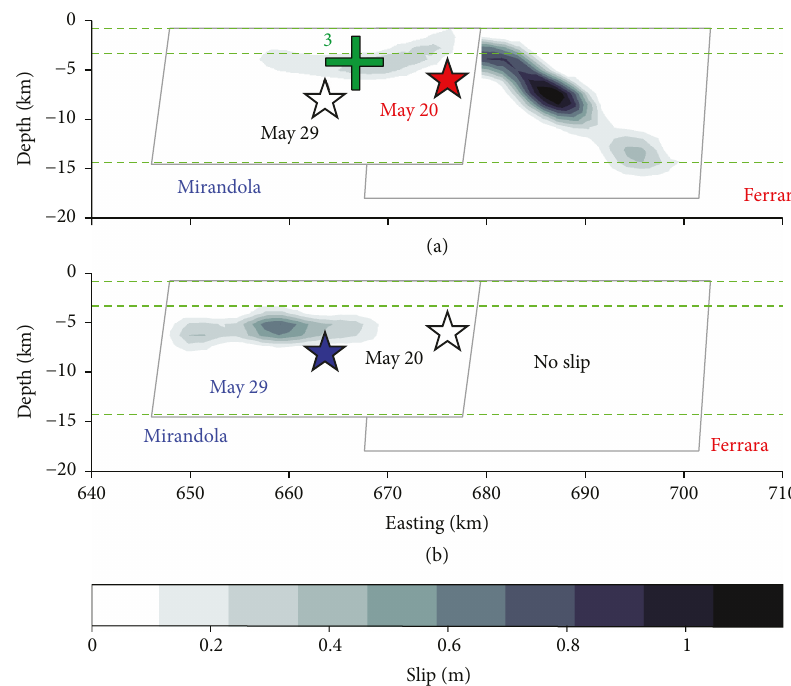
Figure 3: (a) Slip distribution assumed at t = 0 in the S2 simulation. In the case of the S1 simulation, the slip on the Ferrara fault occurs at t = 0 , while on the Mirandola fault at t = 7 days. (b) Slip distribution assumed at t = 9 in S1 and S2 simulations. Red and blue stars represent the location of the May 20 and May 29 hypocenters, respectively. The green cross represents the location of point 3.